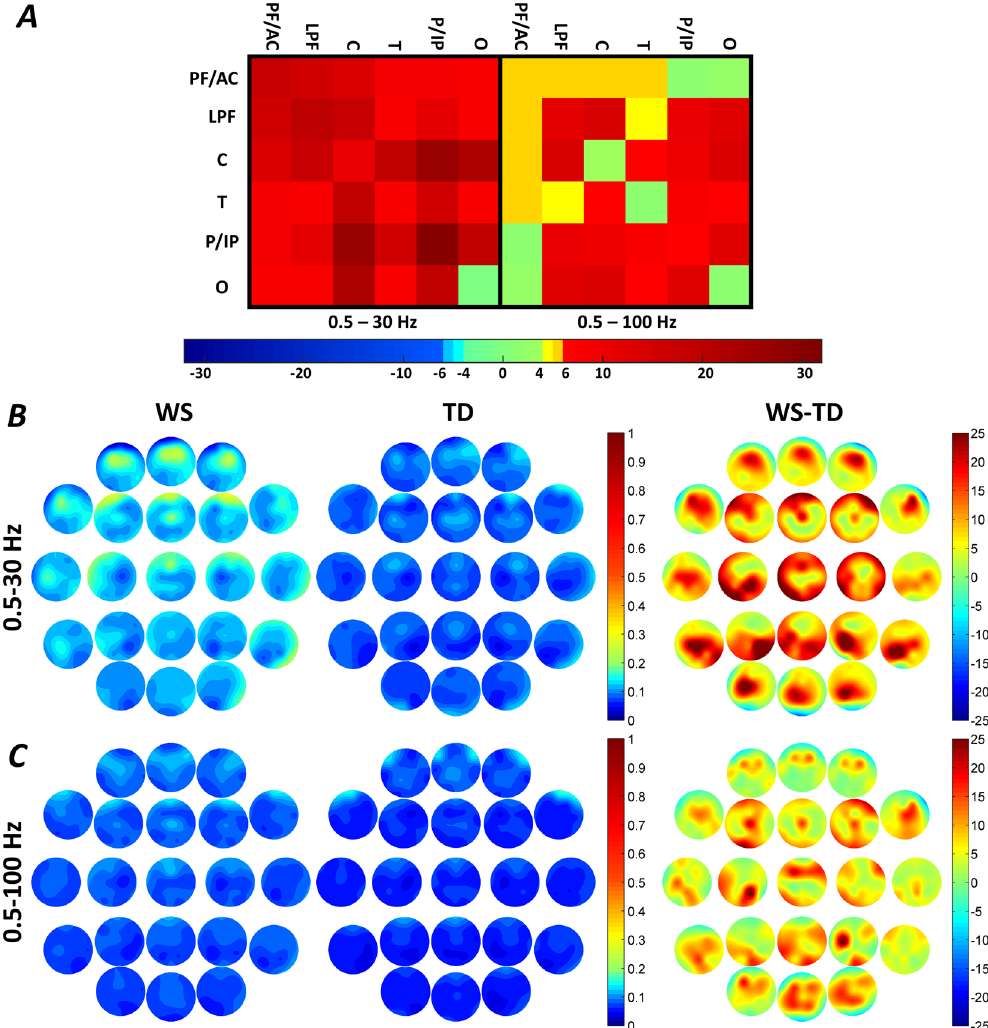
Figure 5. Region-specific REM sleep EEG broadband-1 (0.5–30 Hz) and broadband-2 (0.5–100 Hz) WPLI differences. Broadband-1 WPLIs are significantly higher in Williams syndrome as compared to the typically developing group in several intra- and inter-regional pairings. Color codes: Red = Williams syndrome > typically developing (B-H corrected), Yellow-orange = Williams syndrome > typically developing (uncorrected), Green = Williams syndrome ≈ typically developing, Light blue = Williams syndrome < typically developing (uncorrected), Blue = Williams syndrome < typically developing (B-H corrected). B-C. Broadband-1 and broadband-2 WPLI maps highlighting the patterns of absolute group means (left: Williams syndrome; middle: typically developing) and Williams syndrome-typically developing differences (right). Positions of the maps represent the seed derivation of the synchronization analyses (according to the 10–20 system), while the color patterns are the representations of the variable strengths in the synchronization (WPLI) between the respective region and the seed